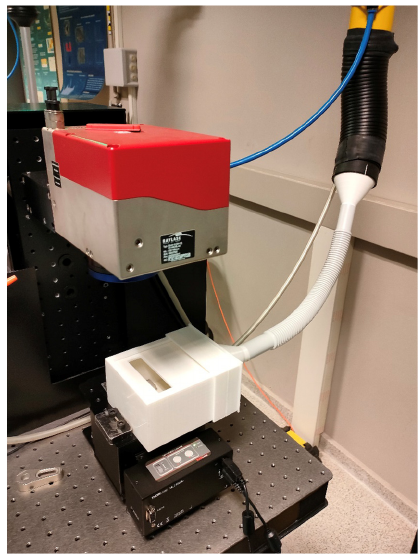
Figure 4. Ad hoc receptacle to collect sample during laser ablation.